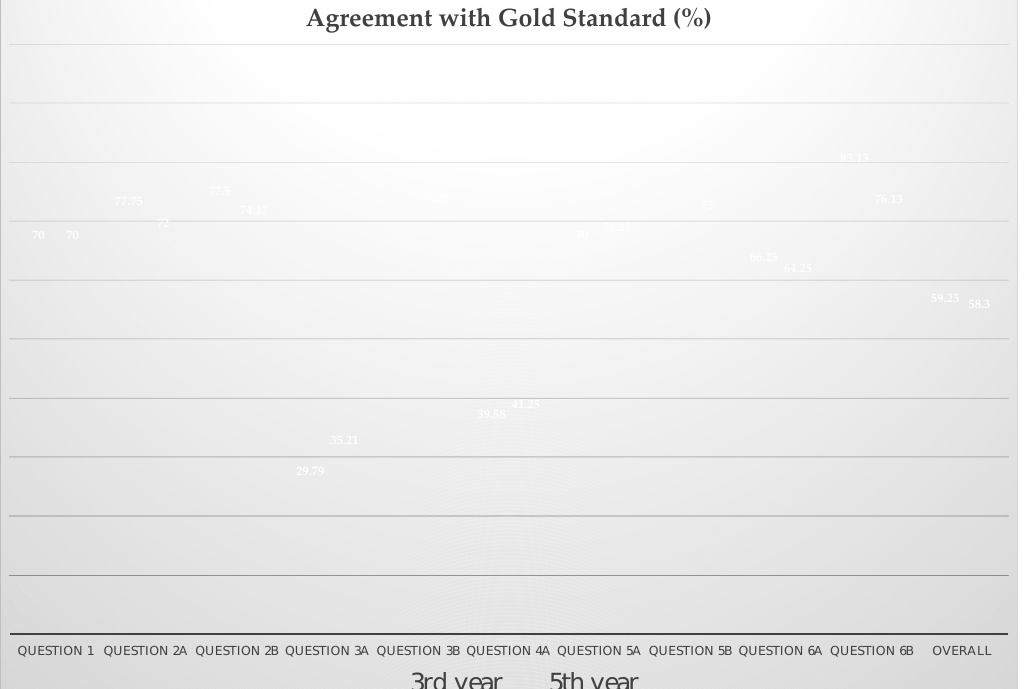
Figure 1. Proportion of correct answers by students of the 3rd and 5th year of studies. Question 1: Clinical staging of MRONJ according to AAOMS. Question 2a: Treatment decision on the basis of clinical findings. Question 2b: Choice of radiographic imaging technique to be decisive before re- ceiving the radiograph. Question 3a: Evaluation based on panoramic radiograph. Question 3b: Choice of further radiographic imaging. Question 4a: Evaluation based on panoramic CBCT. Ques- tion 5a: Radiographic staging of MRONJ according to AAOMS. Question 5b: Choice of radiographic imaging technique to be decisive after receiving the radiograph. Question 6a: Treatment decision on the basis of radiographic findings. Question 6b: Choice of radiographic imaging technique to be decisive for the choice of treatment after receiving the radiograph. Table 2. Proportion of correct answers and agreement with the gold standard. Correct Answers/Agreement with Gold Stand-